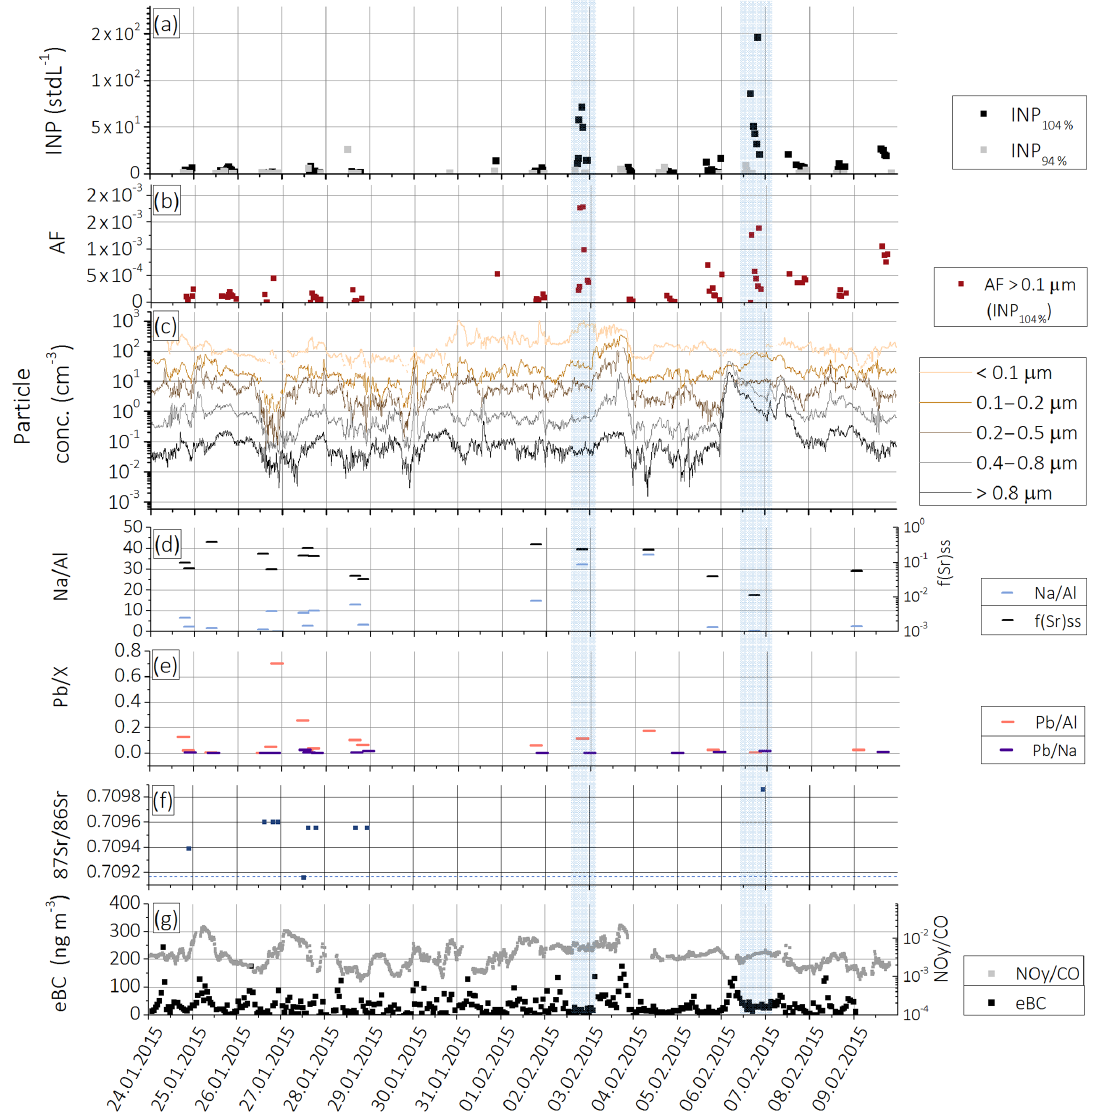
Figure 10. Time series of (a) INP concentrations at 242K and RH w = 104 and 94% measured with HINC; (b) AF of INP 104% considering particles > 0 . 1µm; (c) particle concentrations < 0 . 1, 0.1–0.2, 0.2–0.5µm (SMPS) and 0.4–0.8 and > 0.8µm (OPC), given in volume equiv- alent diameter; cloud water sample analysis, given in ratios of mass of (d) Na / Al and f ( Sr ) ss and (e) Pb / Al and Pb / Na; (f) isotopic ratio 87 Sr / 86 Sr, the dashed line represents the constant value for marine sea salt ( = 0 . 70917); (g) eBC mass concentration and NO